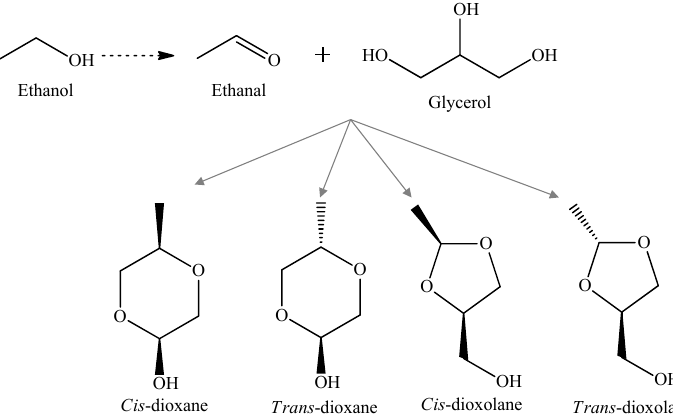
Figure 7. Formation of heterocylic acetals by the acetalization reaction between acetaldehyde and glycerol [103].